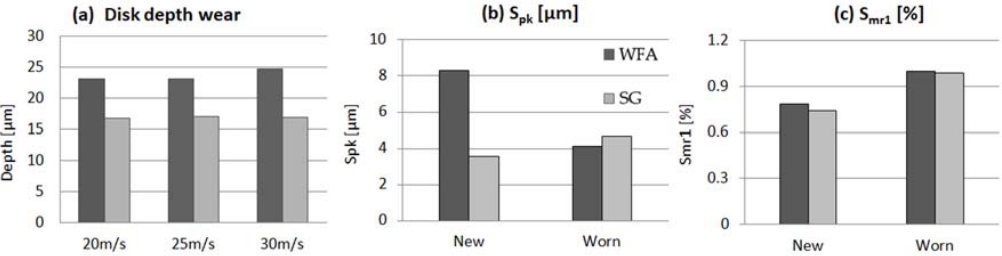
Figure 5. ( a ) Alumina groove depth, ( b ) Reduced peak height and ( c ) peak material proportion of new and worn alumina. and worn